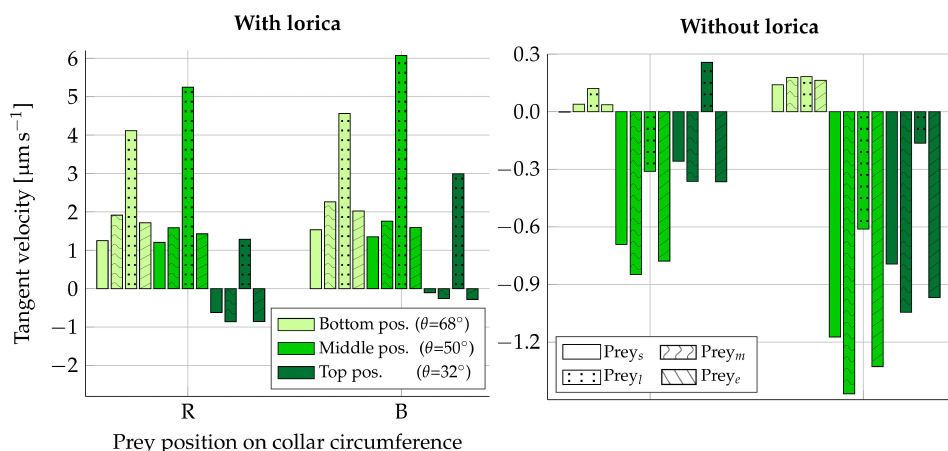
Figure 7. Resultant tangent velocity of fixed prey when using Equations (10) and (11) to convert simulated forces (Table 3) into velocities. Here, a negative velocity is directed towards the cell. The left plot is simulated with the lorica and the right plot without. Velocities are shown for prey placed in the beat plane on the right (R) side of the collar and in the vane plane on the back (B) side of the collar. For each vertical position on the collar ( θ = 68 ◦ , 50 ◦ , 32 ◦ ), the velocity is shown for each type of prey considered: small ( s ), medium ( m ), large ( l ), and elongated ( e ). The two legends apply to both